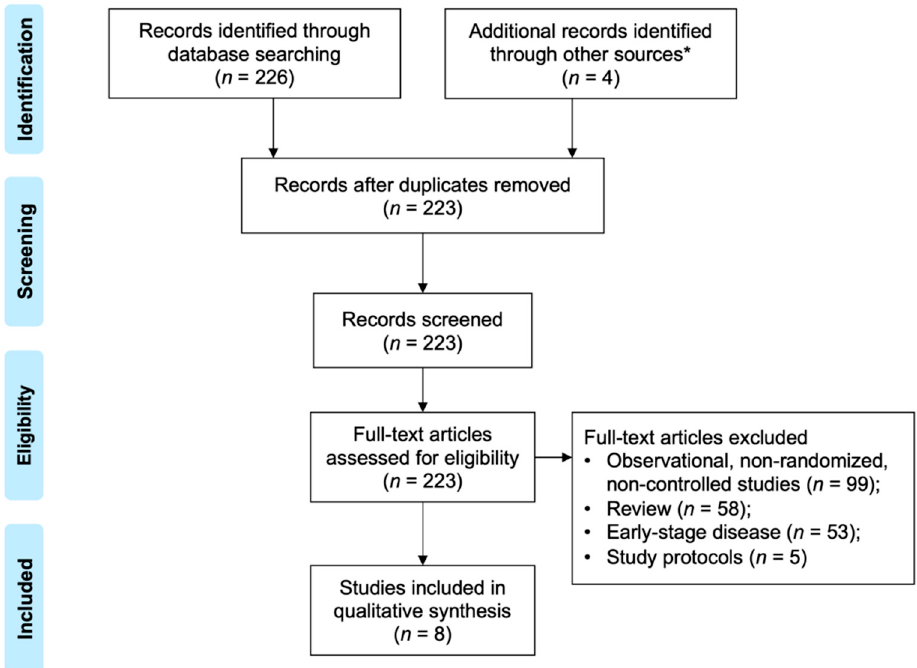
Figure 1. The diagram of study selection and identification. * Conference proceedings including the American Society of Clinical Oncology, European Society of Medical Oncology, and San Antonio Breast Cancer Symposium.